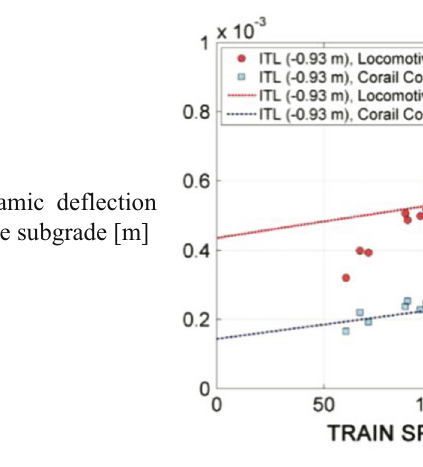
Figure 1: Amplitude of the dynamic subgrade de fl ection [ 23 ] ; static locomotive axle load of 221